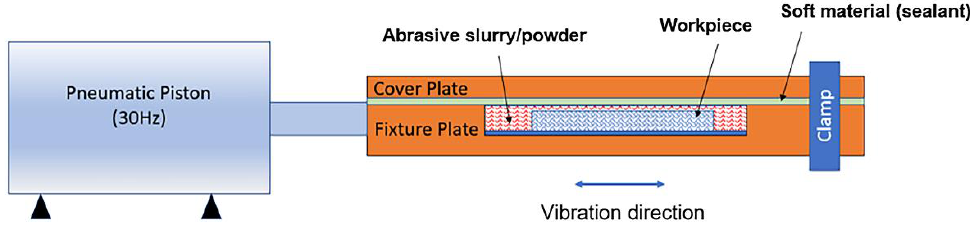
Figure 3. Abrasive polishing device setup.